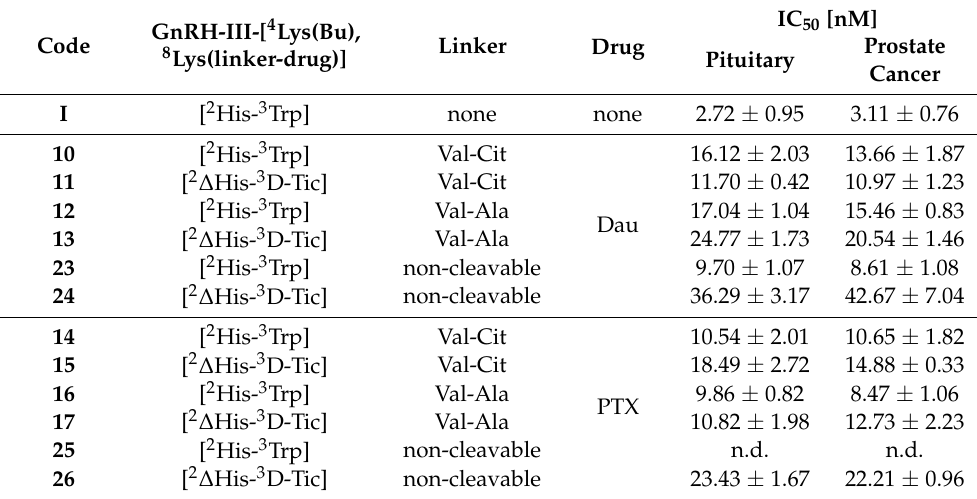
Table 2. Competitive inhibition of [ 125 I][ 6 D-Trp]-GnRH-I binding to membranes of human pituitary and human prostate cancer specimens by GnRH-III-Dau